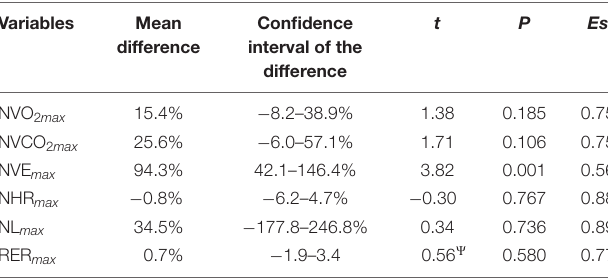
TABLE 3 | Paired samples t -test comparison between vibration and no vibration